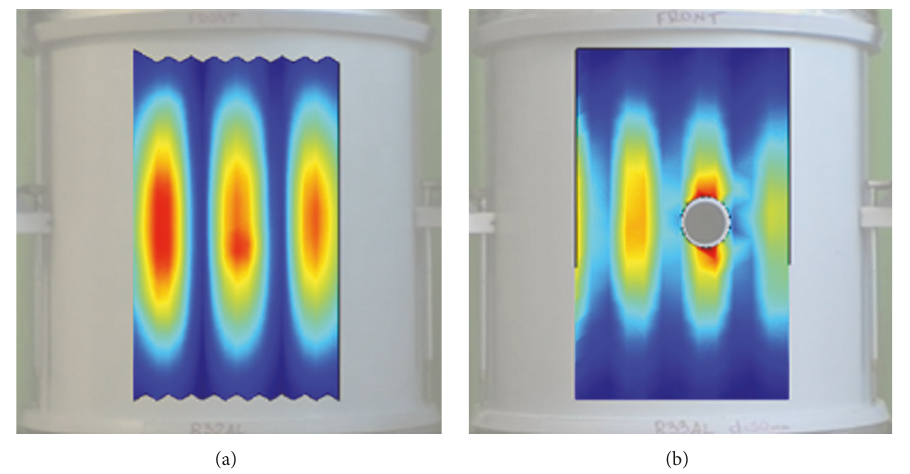
Figure 8: First vibration mode used in VCT of an intact cylinder (a) and a cylinder with cutout (b).